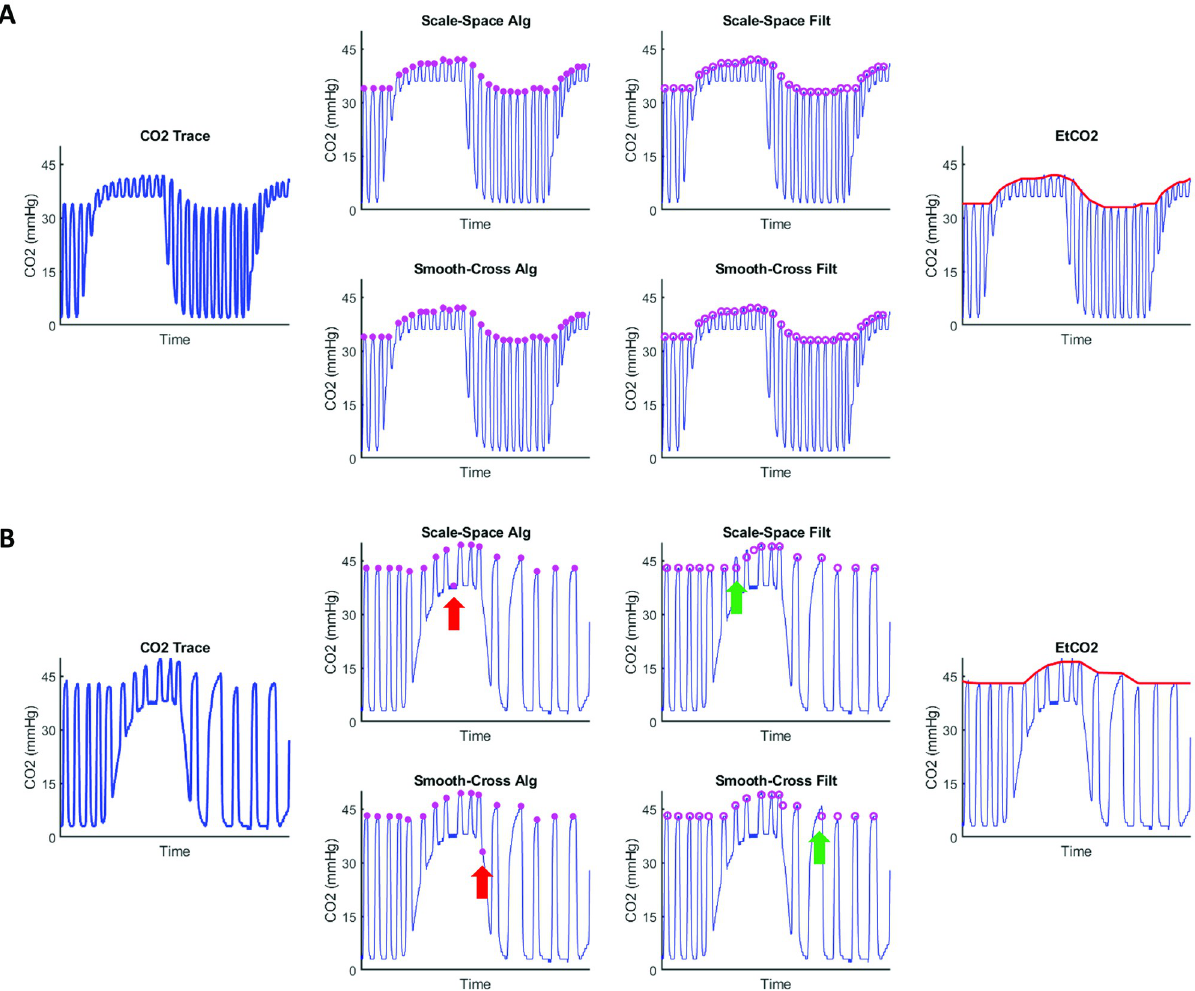
Fig 6. Two examples illustrating the performance of the EtCO2 extraction algorithm. (A) Results from a subject with consistent breathing intervals. Both the Scale-Space and Smooth-Cross algorithms detected the peaks correctly. (B) Results from a subject with variable breathing intervals. Both the Scale-Space and Smooth-Cross algorithms showed instances of underestimating the true EtCO2 curve (red and green arrows). These underestimations were corrected by the final step, which selects the higher value from the two outputs. Plots from left to right: CO2 trace, initil peaks identified by the Scale-Space and Smooth-Cross algorithms, peaks after median filtering, outputs after interpolation and finding the higher value between two algorithms (i.e. the EtCO2 curve).